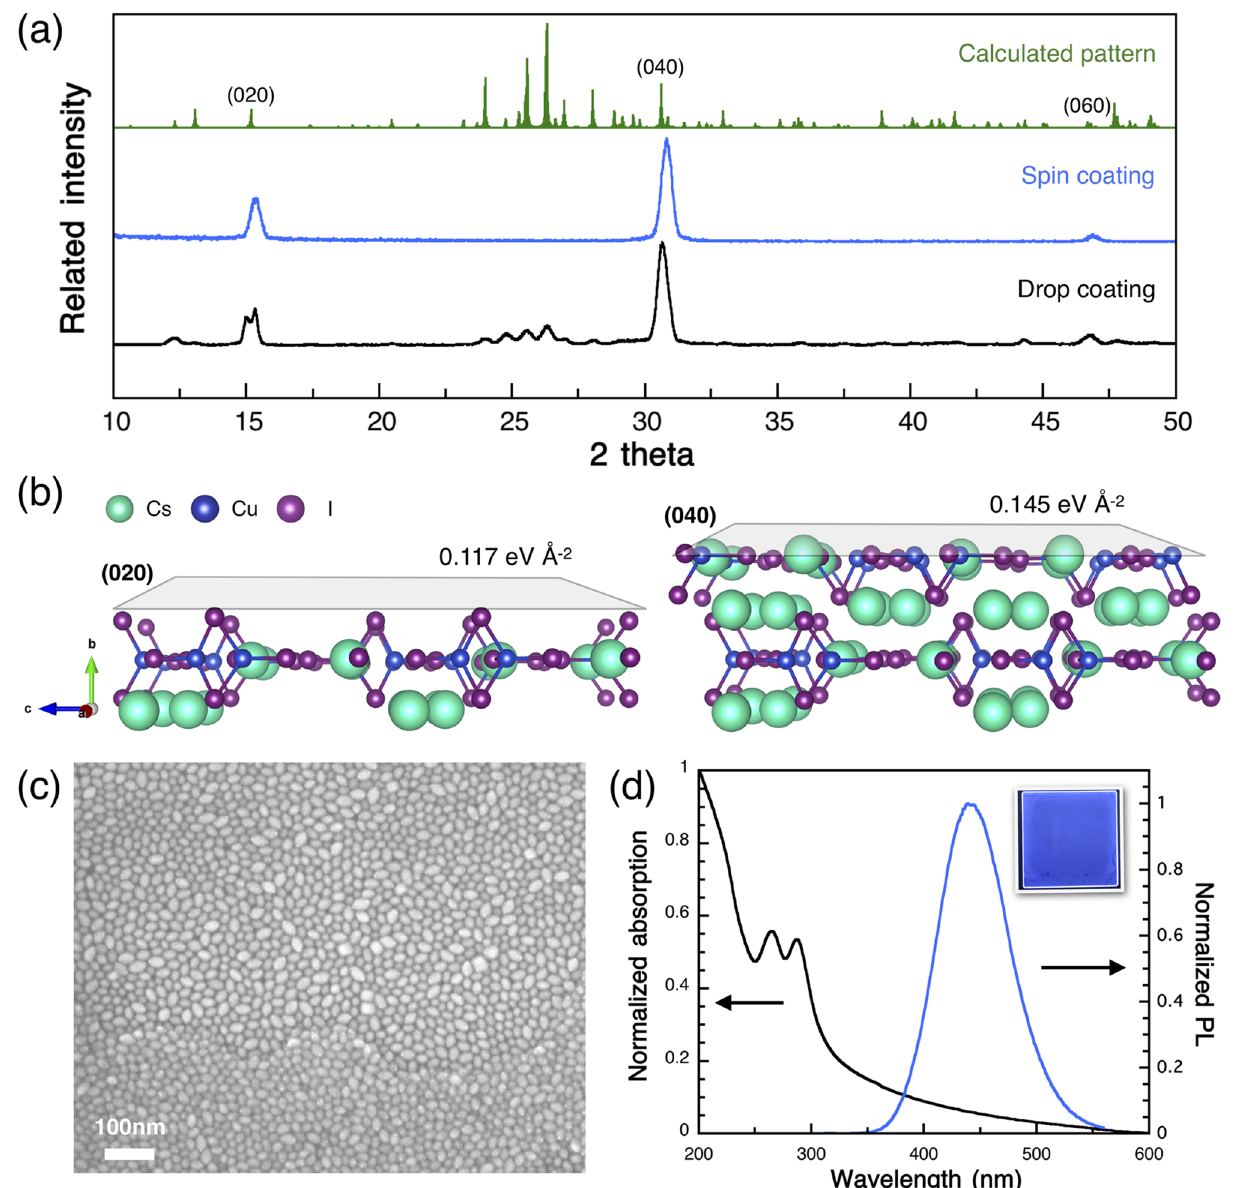
Figure 3. The structure and optical properties of the thin film. ( a ) XRD spectra of spin-coated and drop-coated films, ( b ) crystal structure with different surface directions, ( c ) SEM image of Cs 3 Cu 2 I 5 NC neat film, and ( d ) UV–vis and PL